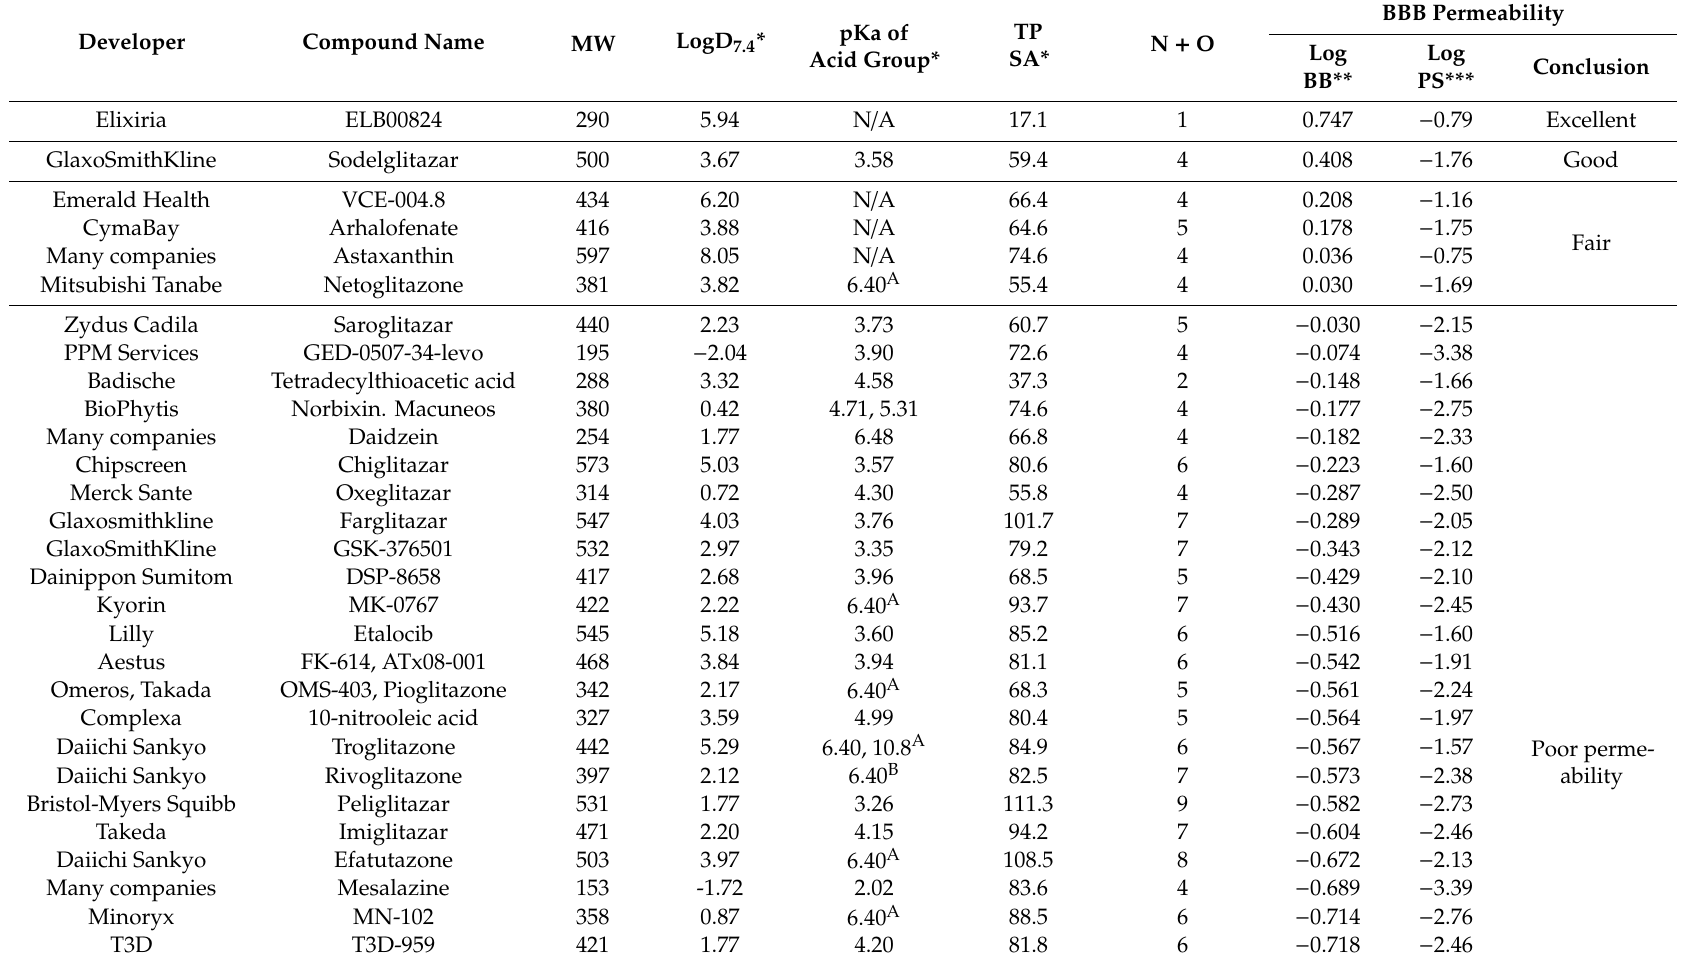
Table 1. Currently available PPAR γ agonists and their Blood–Brain Permeability